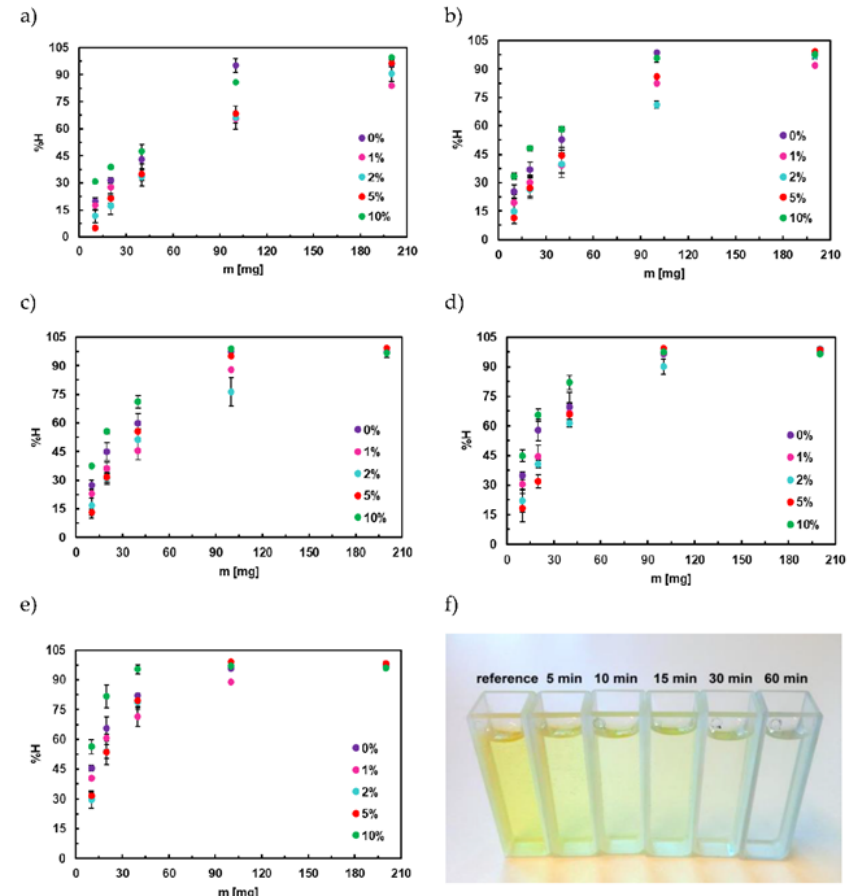
Figure 8. UV-vis adsorption efficiency of Titan yellow dye with contact time ( a ) 5 min, ( b ) 10 min ( c ) 15 min, ( d ) 30 min, and ( e ) 60 min in function of different mass ratios, ( f ) different contact time for Fe 3 O 4 @10%Zn.